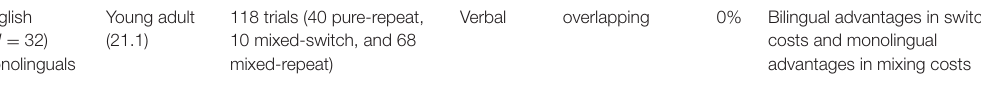
RC b Task-switching mapping a